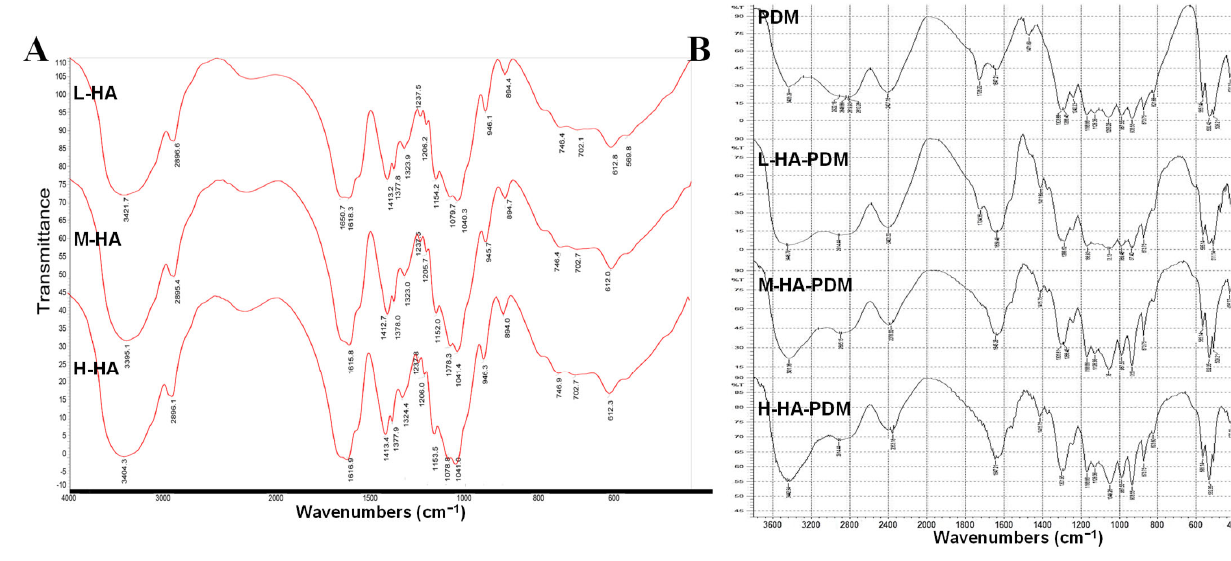
Figure 1. FT ‐ IR. ( A ) HA. ( B ) PDM and HA–PDM. Figure 1. FT-IR. ( A ) HA. ( B ) PDM and HA–PDM.